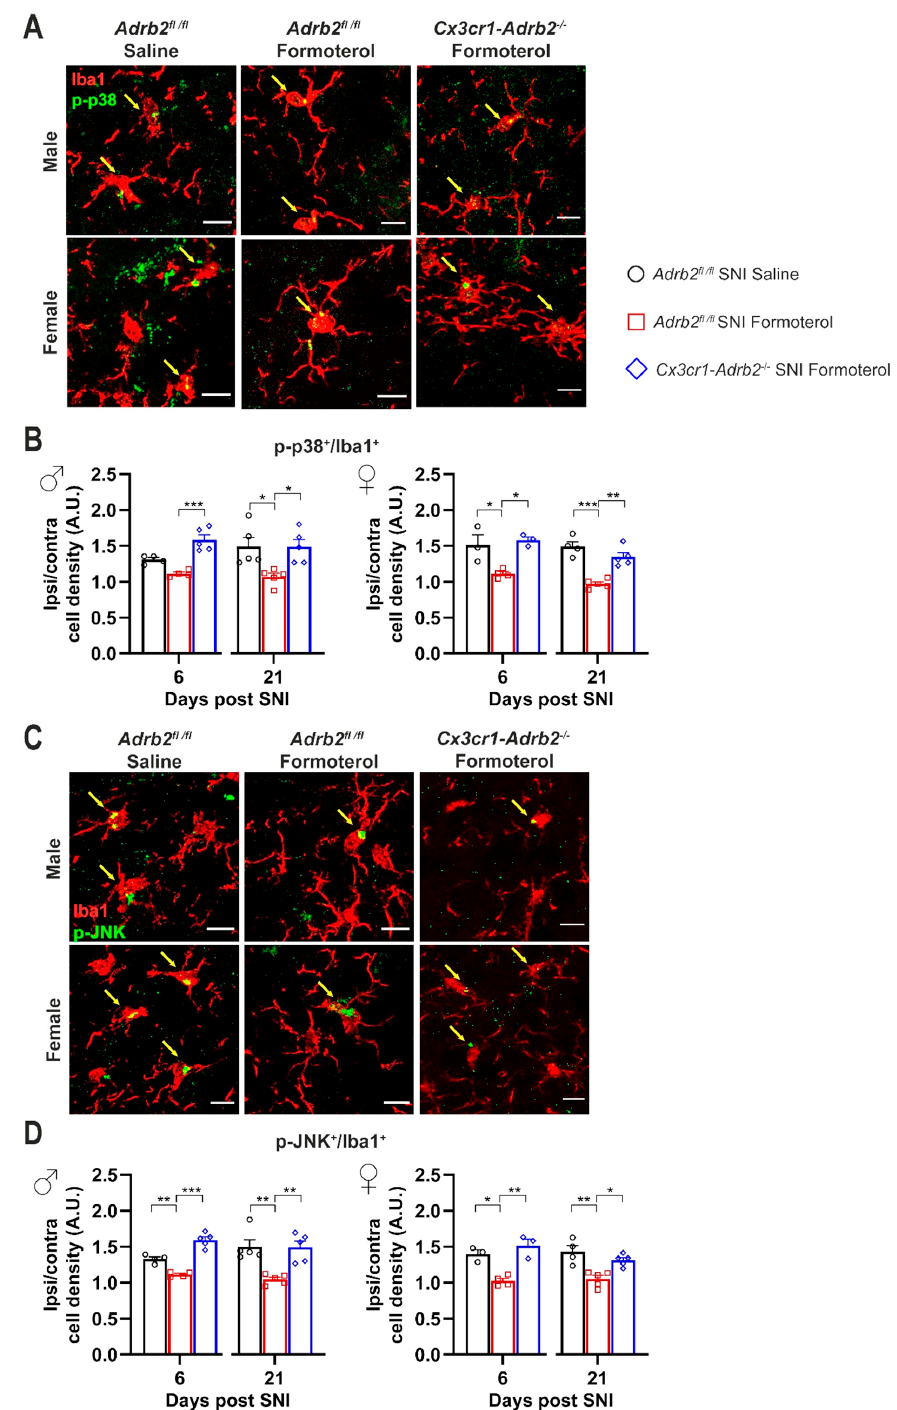
Figure 8. Microglial β 2-AR knockdown impairs the Formoterol effect of lowering microglial activation markers levels in the ipsilateral spinal dorsal horn of SNI-operated mice. ( A ) Typical examples of colocalization of Iba1-positive cells and p-p38, the microglial activation markers in the spinal dorsal horn (SDH) of male and female mice, six days after SNI operation in control and transgenic mice injected with saline or Formoterol. Double-positive cells are pointed by arrows. Scale bar = 10 µ m. ( B ) Analysis of the co-staining of Iba-1 immunohistochemistry and p-p38 of control and Cx3cr1-Adrb2 -/- male (left) and female (right) mice treated with saline or Formoterol, 6 and 21 days after SNI operation. Ipsi/contra = ratio between the ipsilateral and contralateral